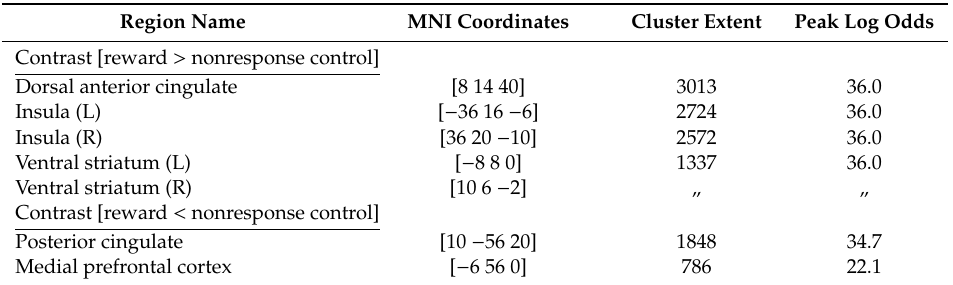
Table 2. Peak voxel coordinates for region-of-interest